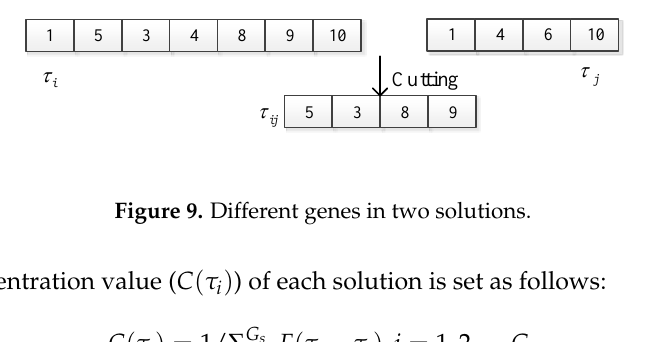
Figure 9, the distance factor F of two solutions is set based on the length of their different genes F ( τ i − τ j ) = Length ( τ ij ) , and the arrow represents the elimination of the similar genes.